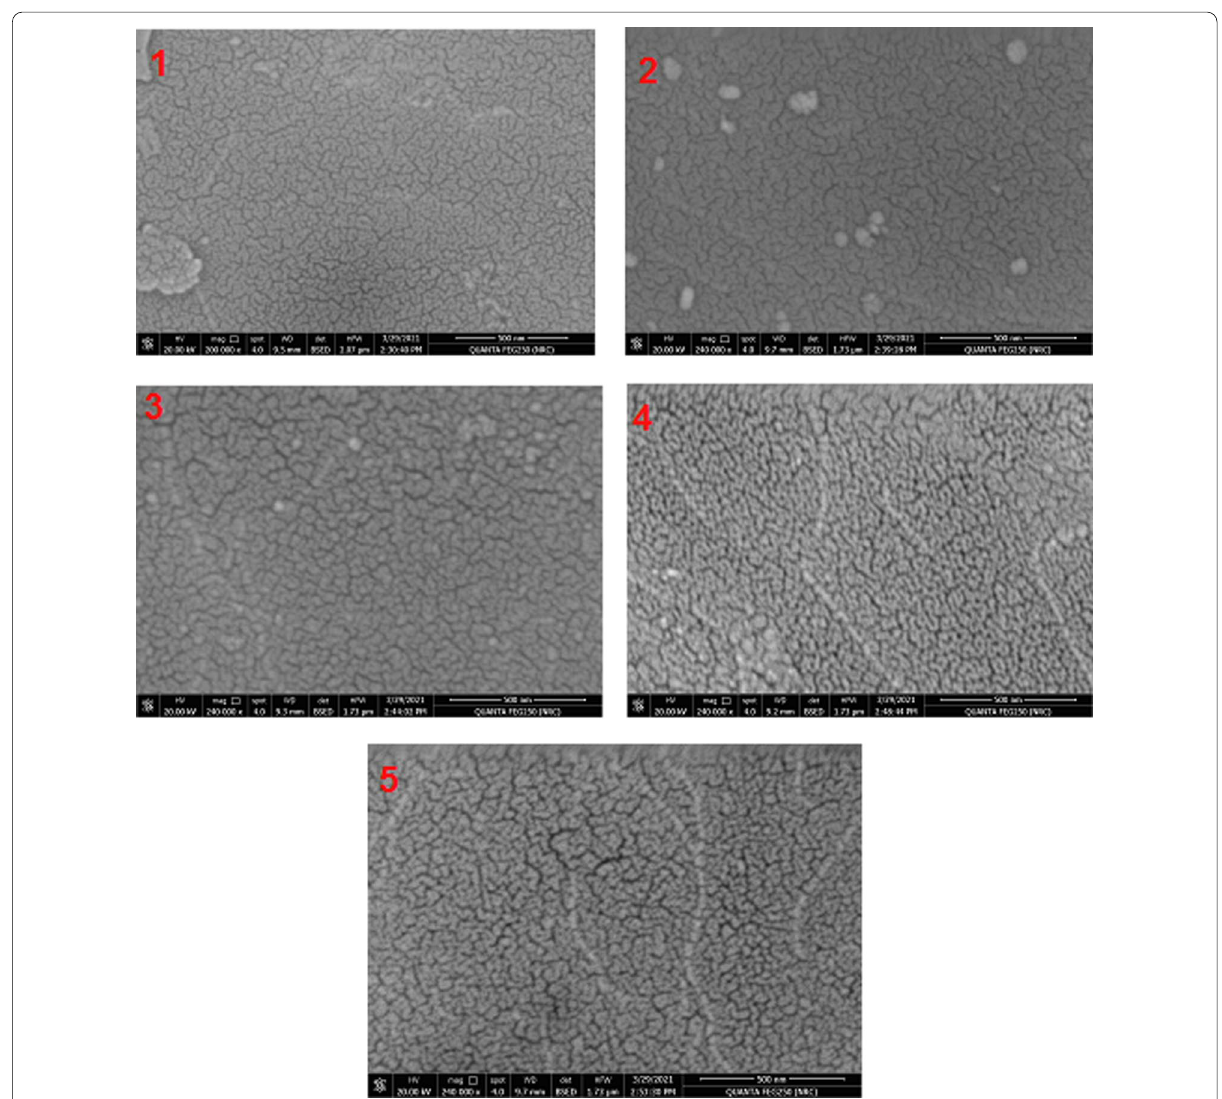
Fig. 3 Scanning electron microscope images of the electrolytically colored aluminum samples by (1) Ni, (2) mixture of Ni/Cu, (3) Cu for 20 min, (4) Cu for 30 min and (5) Cu for 60